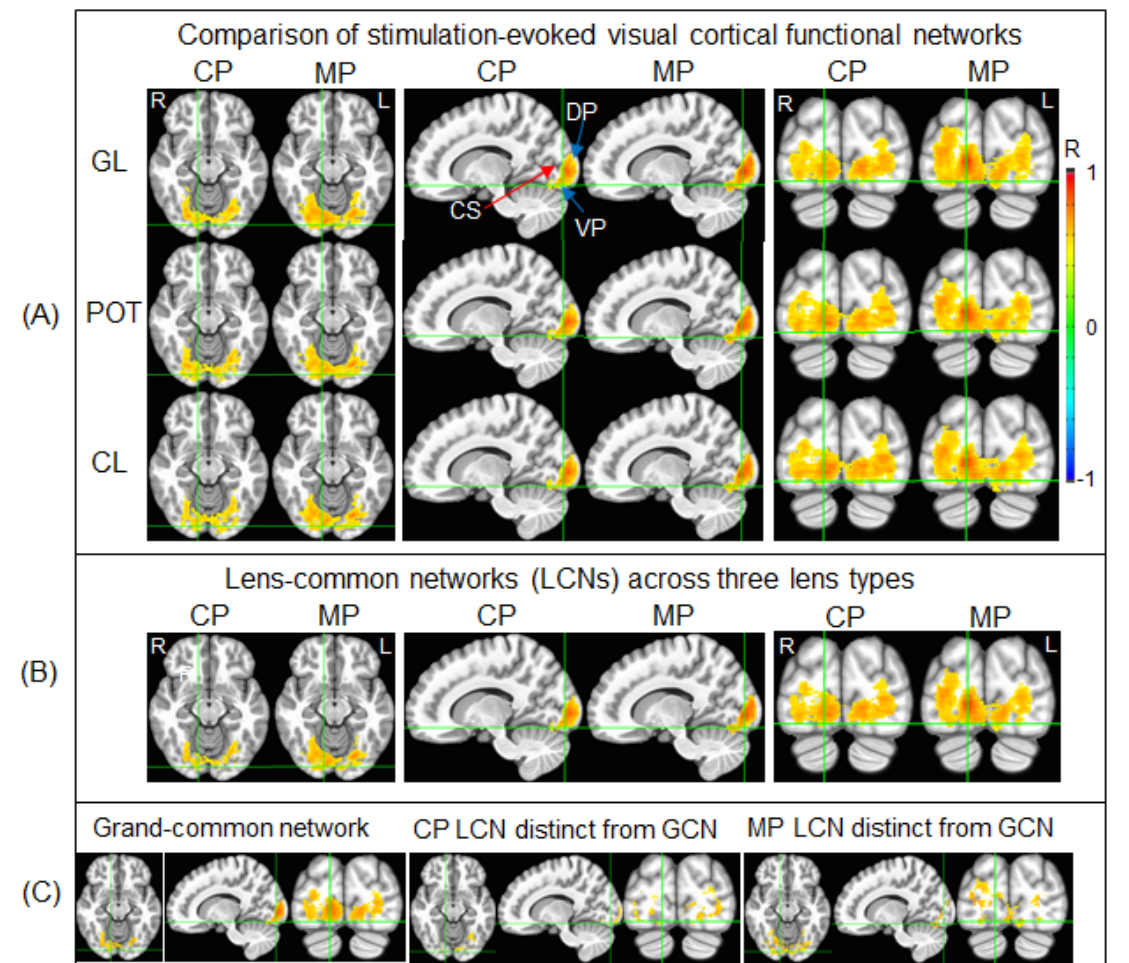
Figure 4. Illustration of the stimulation-evoked visual cortical functional networks. ( A ): For each participant and each lens type, a Pearson correlation coefficient (R) map was first computed using the signal time course of the selected stimulation- associated FAUPA in area V1 (Figure 3A) as the reference function; then, for each group, in the standard space, the group-mean R map was computed with threshold R > 0.5 to yield the stimulation-evoked visual cortical functional network for that group. The stimulation evoked the cortical representation of the foveal vision in V1 near the occipital pole with a narrowed width of the activated area along the calcarine sulcus (CS) that represents the eccentricity axis of the visual field from the center to periphery, consistent with the small visual field of the stimuli (10° high and 13° wide). As expected, the activation propagated along both the dorsal pathway (DP) and ventral pathway (VP). CP: control participants; MP: migraine patients; GL: gray lens; POT: precision ophthalmic tint; CL: color lens; R: right; L: left. ( B ): For each group, the lens-common network (LCN) shared by all three functional networks of the three lens types. ( C ): The grand-common network (GCN) shared by the two LCNs (left), the CP’s LCN distinct from the GCN (middle), and the MP’s LCN distinct from the GCN (right), respectively.